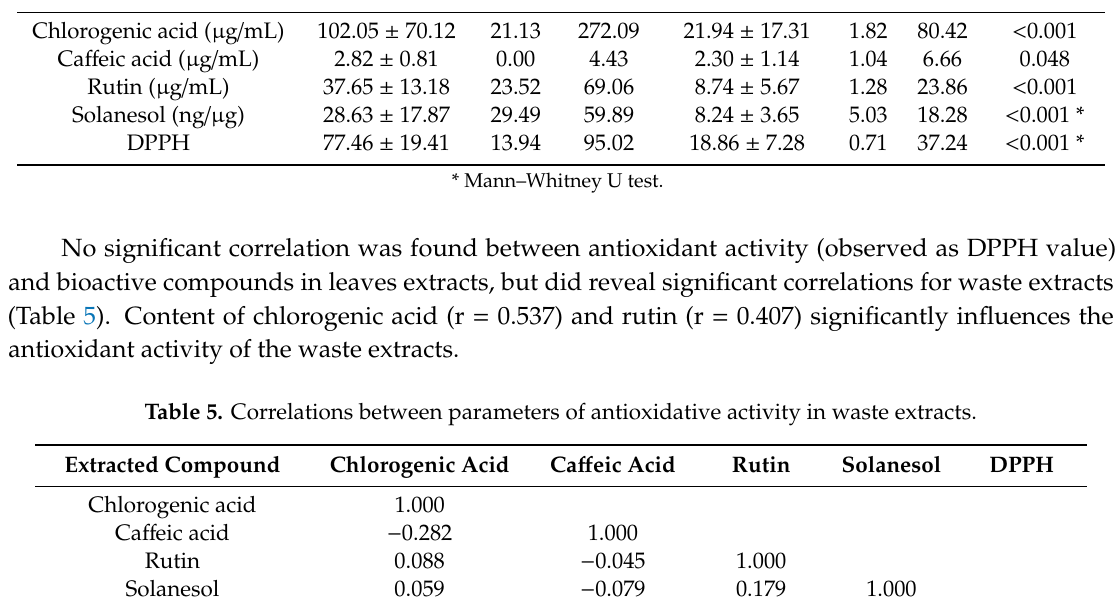
Table 4. Determined bioactive compounds and antioxidant activity in leaves and waste extracts. Leaves Extracts Extracted Compound